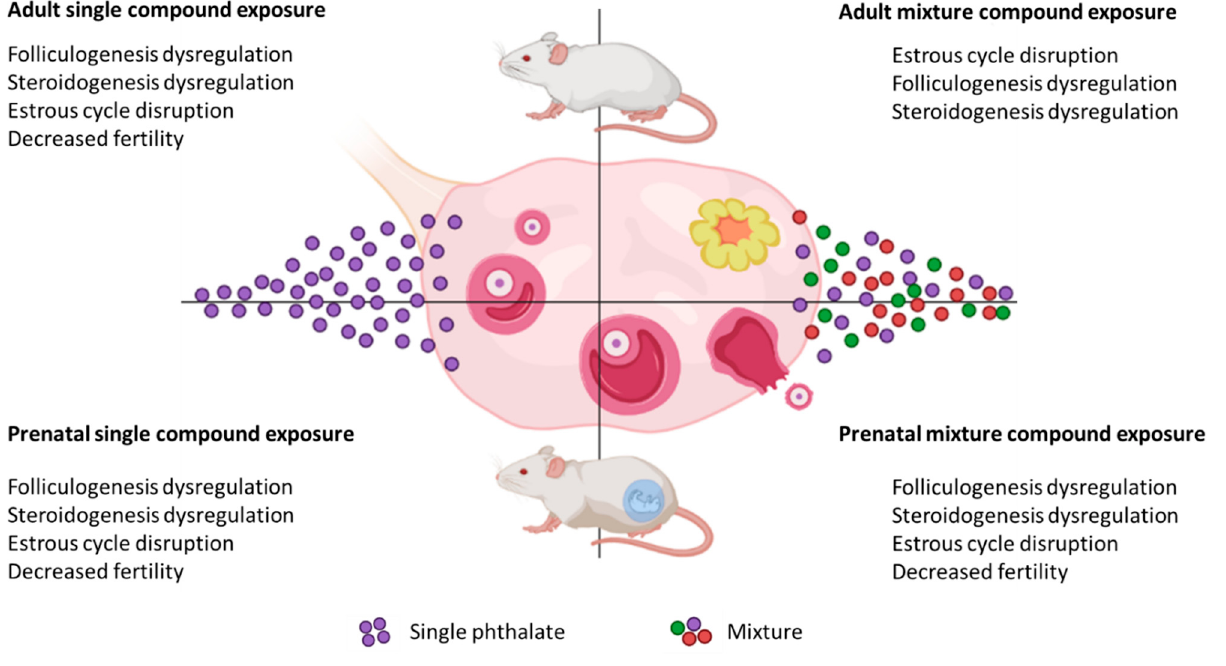
Figure 2. Effects of phthalates on female reproduction. The schematic shows that exposure to single phthalates as well as mixtures of phthalates affects several similar ovarian and female reproductive outcomes in mice.